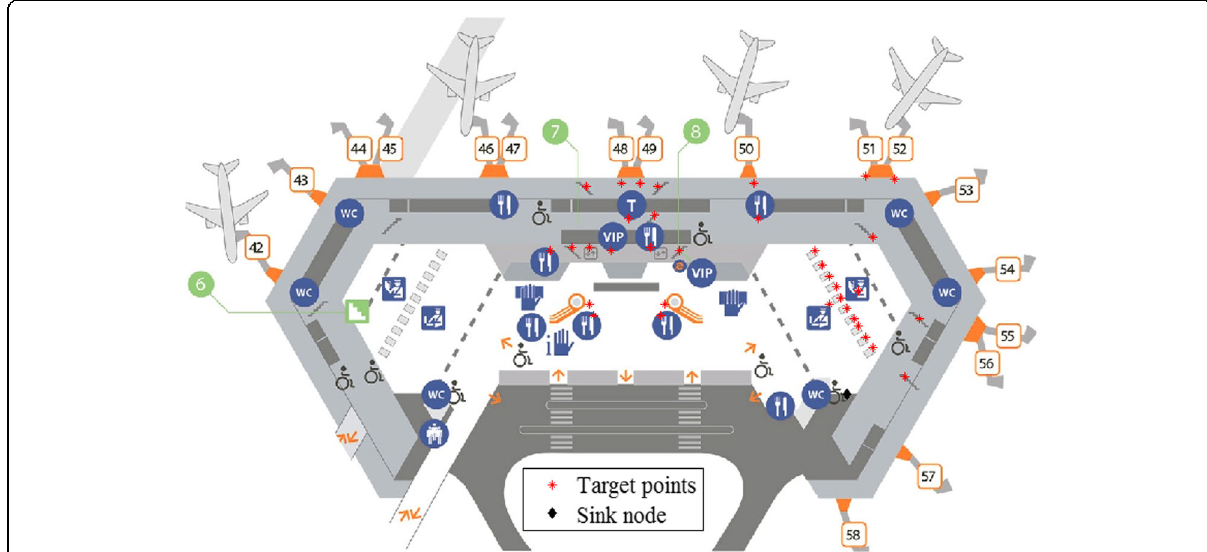
Fig. 5 Schematic of an international airport terminal with the marked positions of the target points and sink node for case 5 in Table